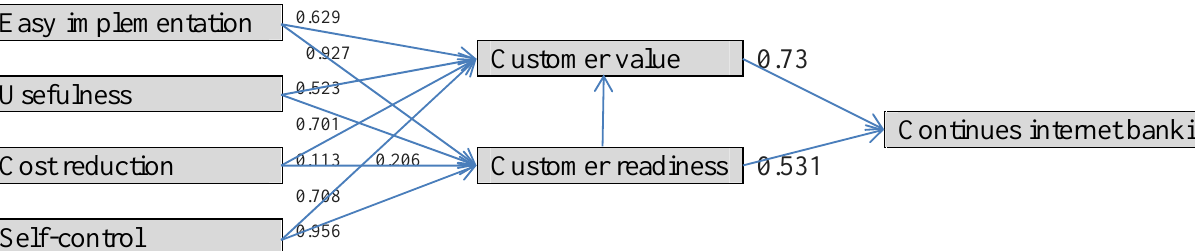
Fig. 2. The results of Pearson correlation